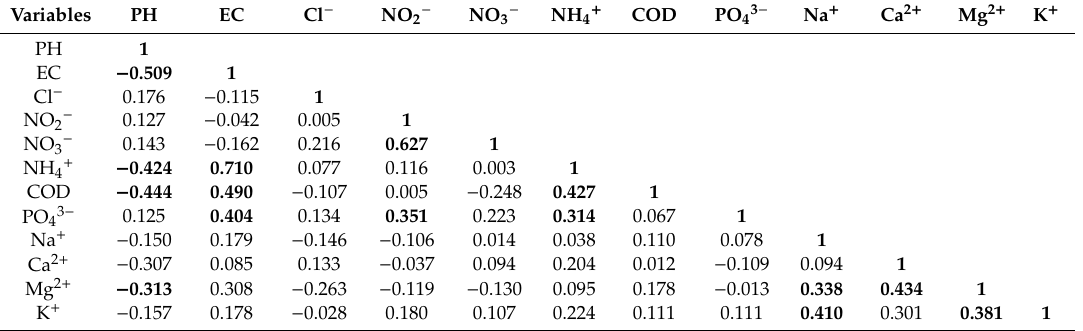
Table 3. Correlation matrices in the wet season using Spearman rank–order.